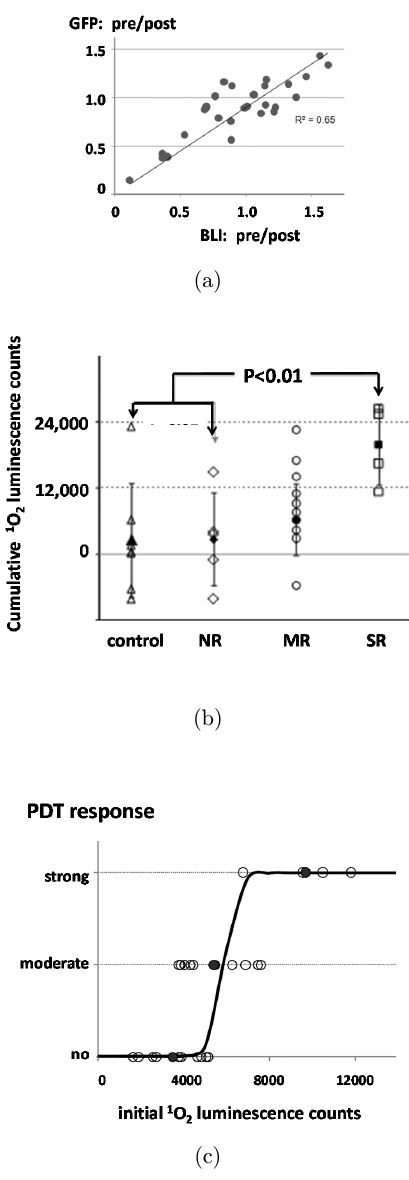
Fig. 3. (a) Correlation between GFP and bioluminescence imaging, plotting in each case the ratio of the integrated image signal before and at 5 d after PDT treatment: each point corre- sponds to an individual tumor. (b) Cumulative luminescence counts in individual tumors (open symbols) and averaged over all tumors (solid symbols) for each of the BLI treatment response groups. Note that the negative data points are the results of noise in the background subtraction at low 1 O 2 signal levels. (c) Sig- moidal BLI response plot, using the initial 1 O 2 luminescence counts at the start of PDT treatment as the dose metric, which is an alternative to the cumulative SOLD counts used in